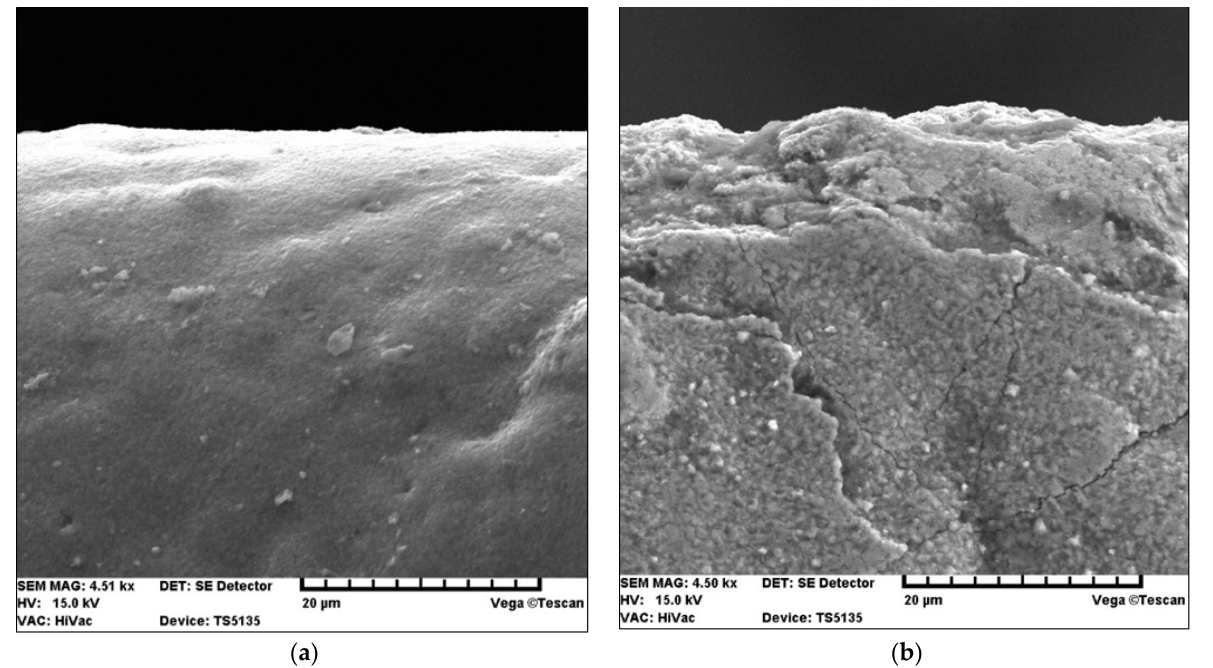
Figure 14. Secondary electron images (SEIs) of SM 25 cutting tool blades coated with ( a ) TiN and ( b ) TiN + (TiAlSi)N + TiN, after heating with 40% of the maximum laser power.